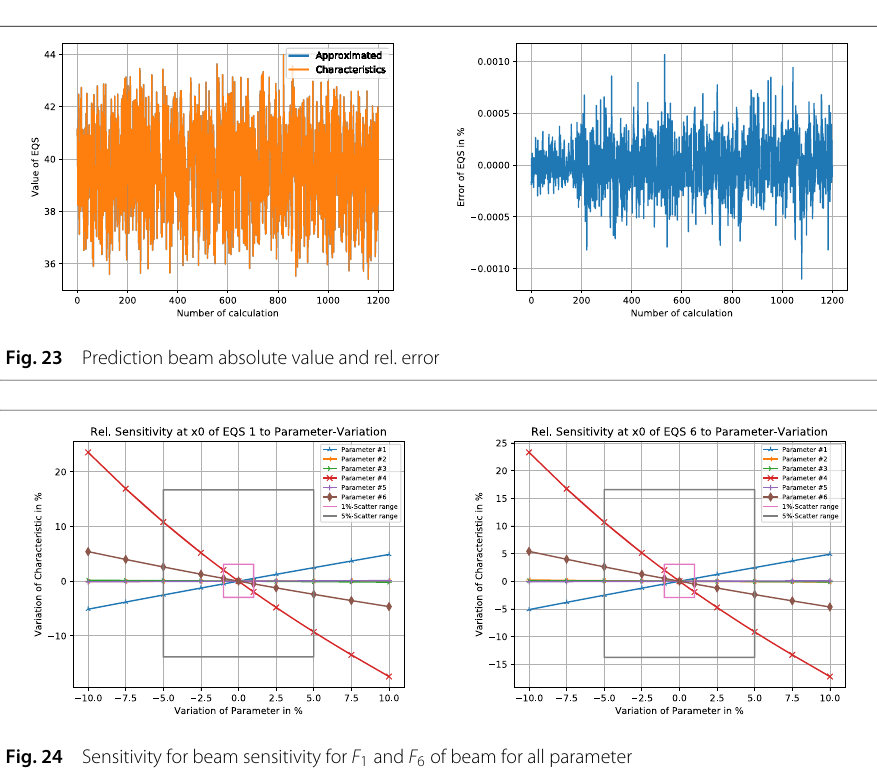
Fig. 24 Sensitivity for beam sensitivity for F 1 and F 6 of beam for all